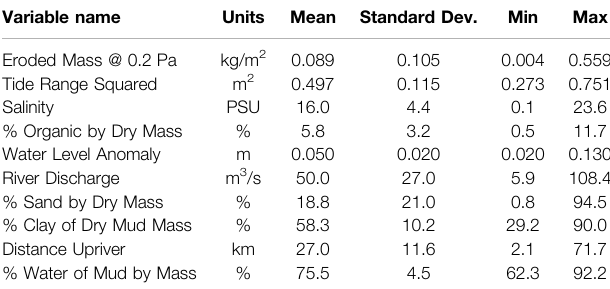
TABLE 2 | Data and variance statistics for variables prior to log transformation or standardization, but after low-pass averaging recent tidal range squared, water level anomaly, and river